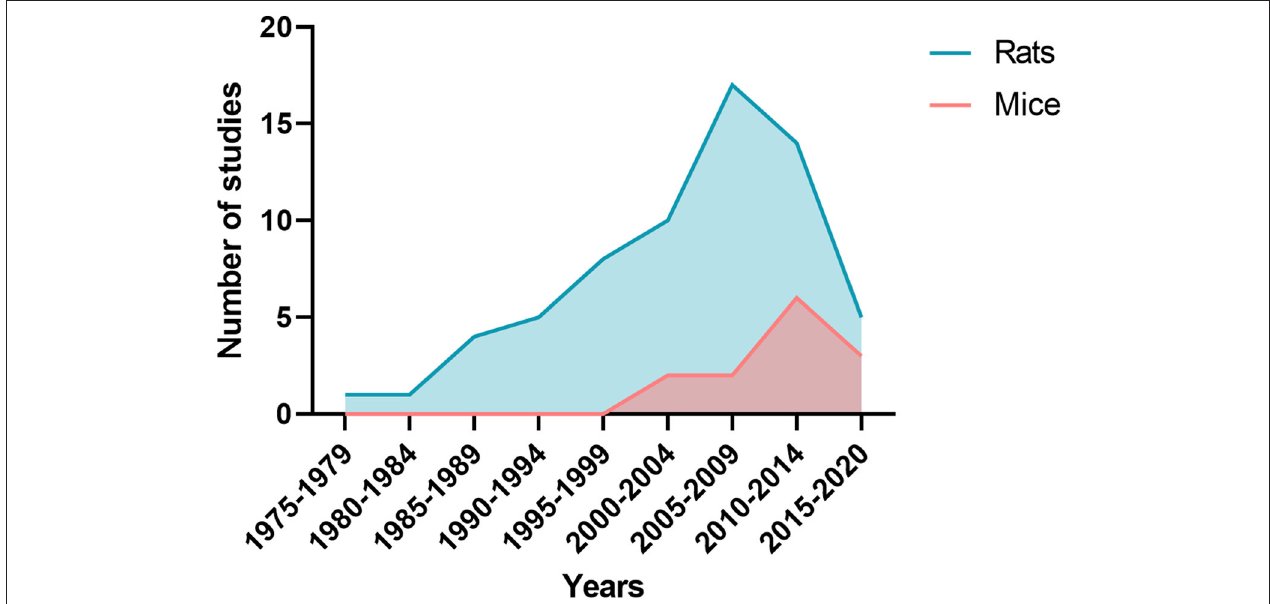
FIGURE 4 | Number of publications by five-year periods depending whether studies were performed on rats or